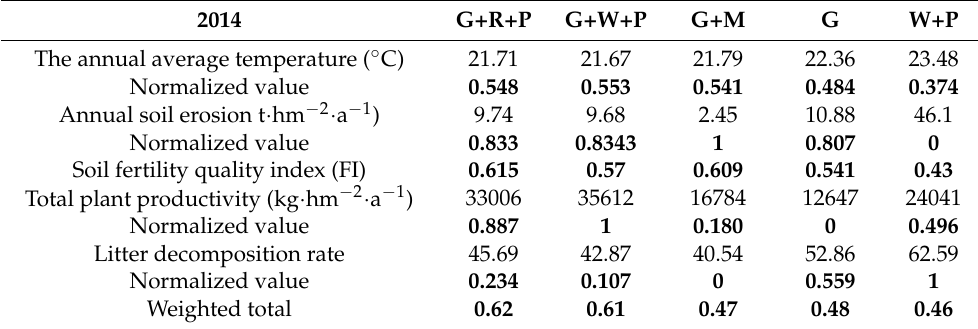
Table A4. Ecological indicator values from three mixed Ginkgo systems, pure Ginkgo (G), and a cropping system (W+P), in 2014.